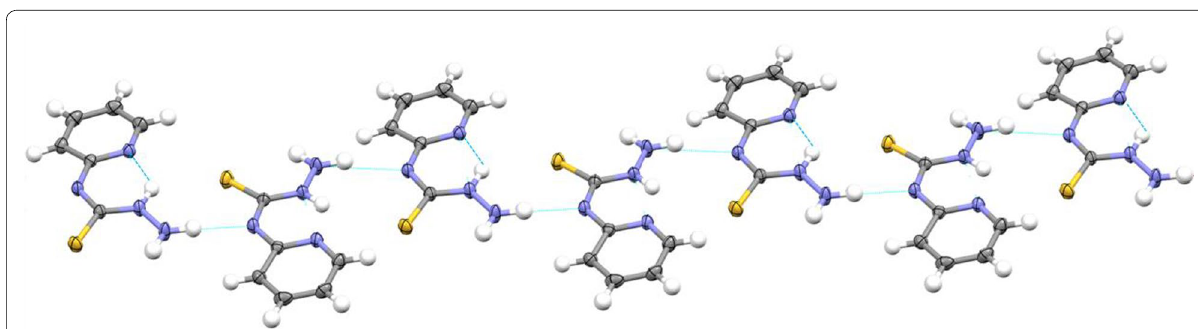
property on a studied molecular surface. The most nega- tive electrostatic potential on N -(pyridin-2-yl)hydra- zinecarbothioamide surface is related to the nitrogen (N1) of pyridine ring, V S,min 41.62 kcal mol − 1 , fol- = − lowed by weaker value 38.6 kcal mol − 1 on the sulfur − (S10). Thus, V S (r) would wrongly predict electrophilic attack to occur preferentially at the nitrogen. In con- I trast, the lowest values of S (r) placed on the (S10), with I 1 ; also, there is an I S,min = 159.79 kcal mol − S,min by the hydrogen (H18), but it is much higher, 165.39 kcal mol − 1